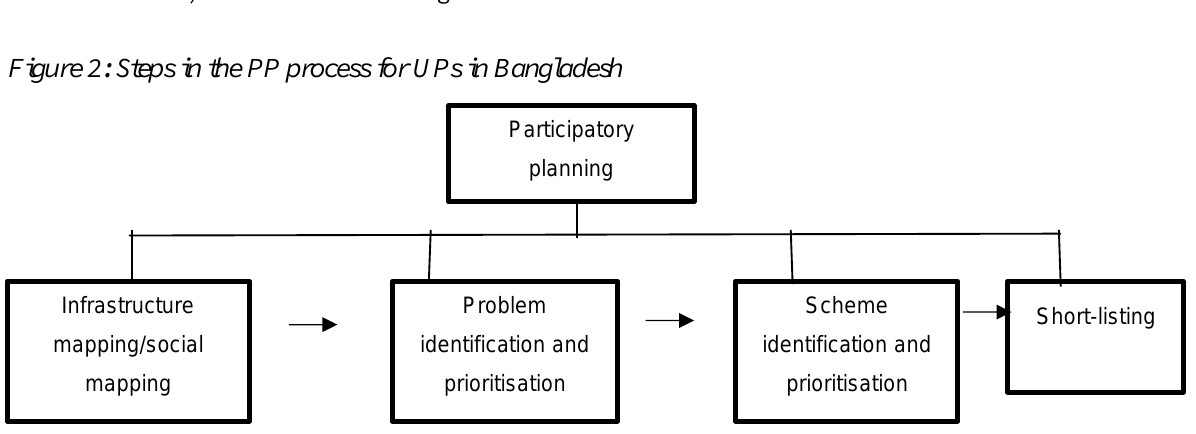
Source: GoB (2012a) and cited in Rahman